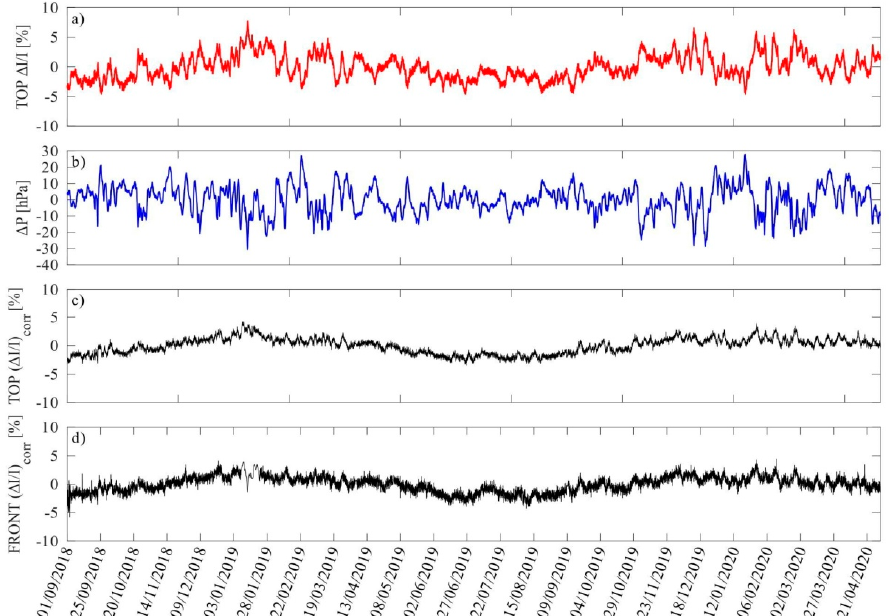
%/hPa. ( b ) Pressure corrected data; correlation coefficient reduced to (cid:1870) (cid:2870) = −0.08.